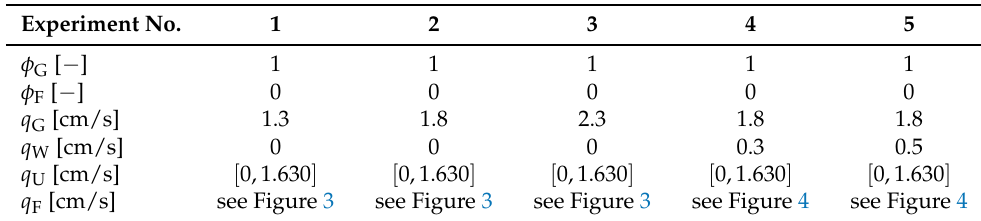
Table 3. Overview of the five steady-state